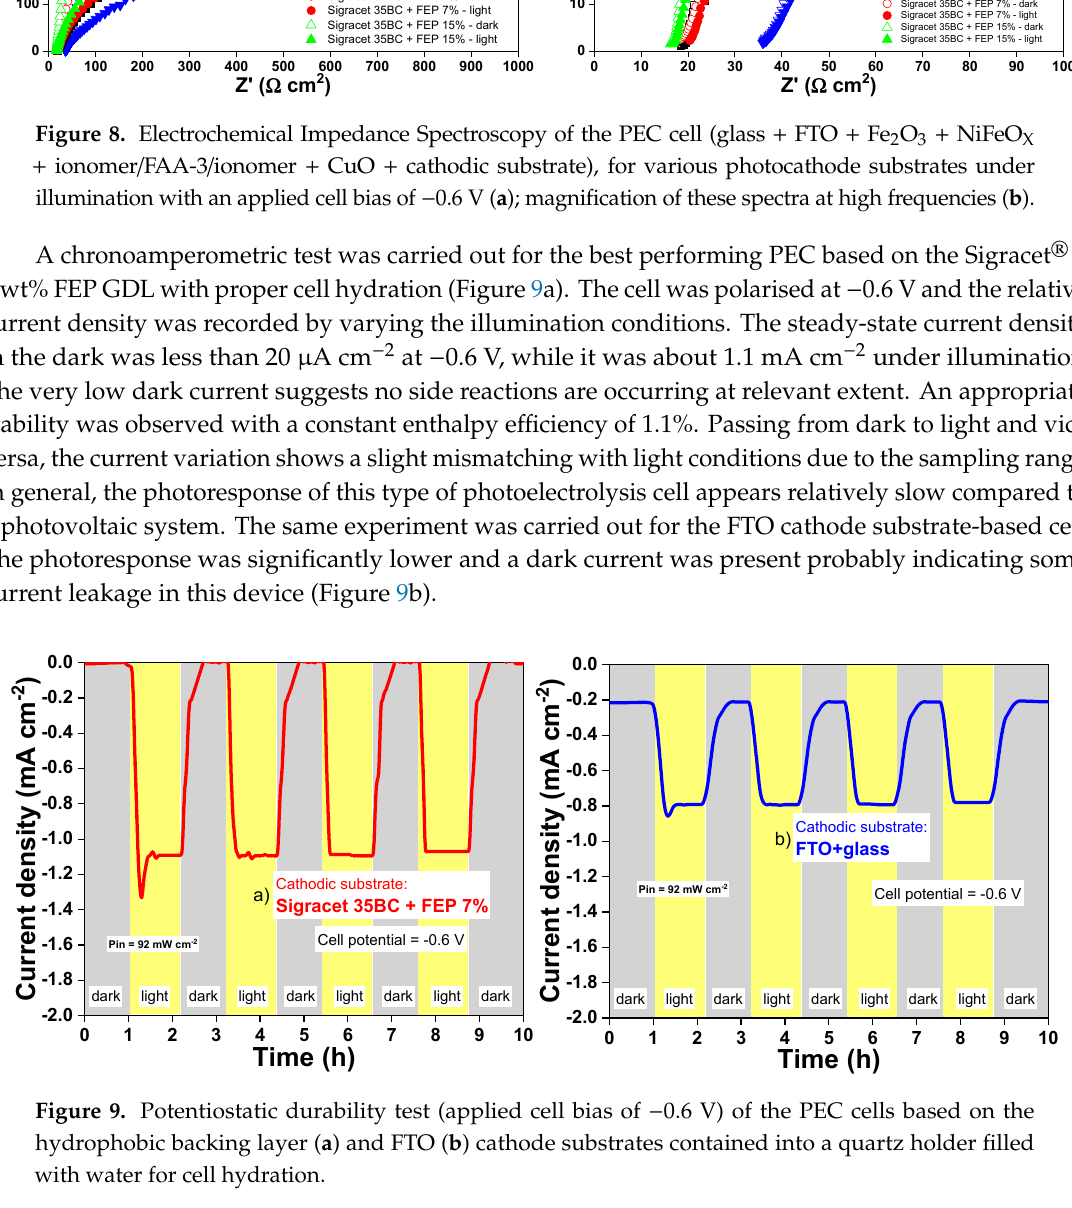
Figure 8. Electrochemical Impedance Spectroscopy of the PEC cell (glass + FTO + Fe 2 O 3 + NiFeO X + ionomer/FAA-3/ionomer + CuO + cathodic substrate), for various photocathode substrates under illumination with an applied cell bias of − 0.6 V ( a ); magnification of these spectra at high frequencies ( b ).